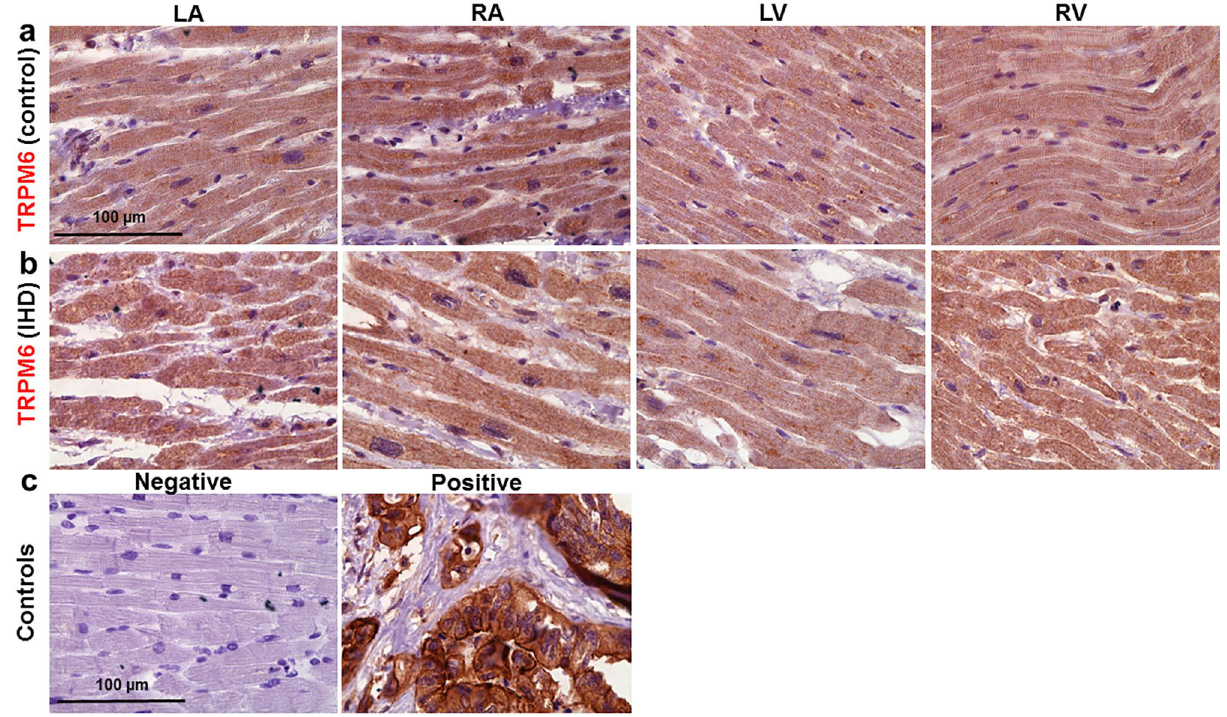
Figure 8. Representative histotopograms of TRPM6 images in the four chamber walls of the human heart. ( a ) Control subject after traffic accident. ( b ) IHD patient. The intensity of the brownish pigments shows areas with expression of TRPM6 in the heart (× 40 magnification). ( c ) Negative control ( left ) in the LV, and positive control ( right ) of TRPM6 in tumour of the colon (× 40 magnification). Scale bars indicate 100 µm. Other notations are the same as in Fig.